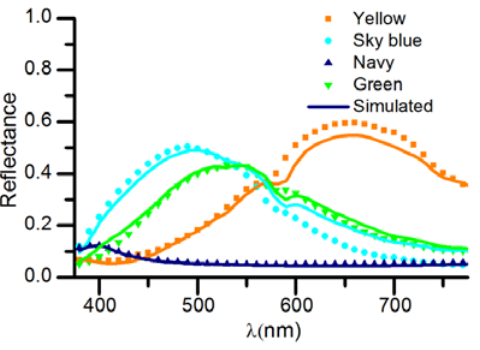
Table 1. Film thicknesses (in nm) for coatings with different aesthetic appearances.